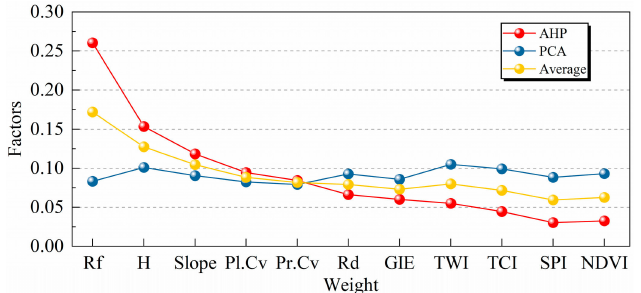
Figure 6. Results of combined weights of each impact factor.